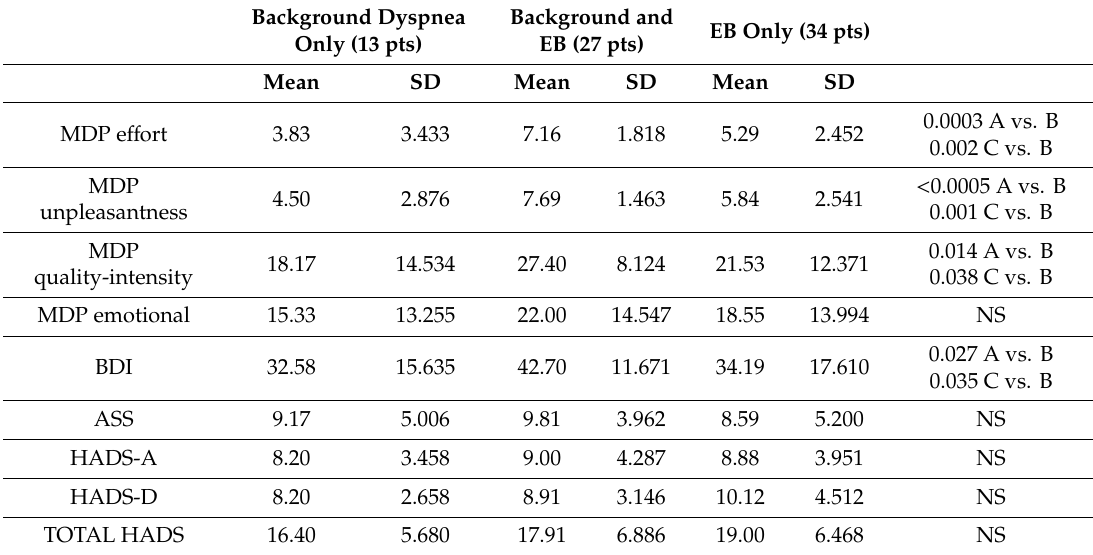
Table 3. Di ff erences in MDP items, ASS, HADS-A, HADS-D, and total HADS (see text) in patients with background dyspnea, background dyspnea and EB, and EB alone (see